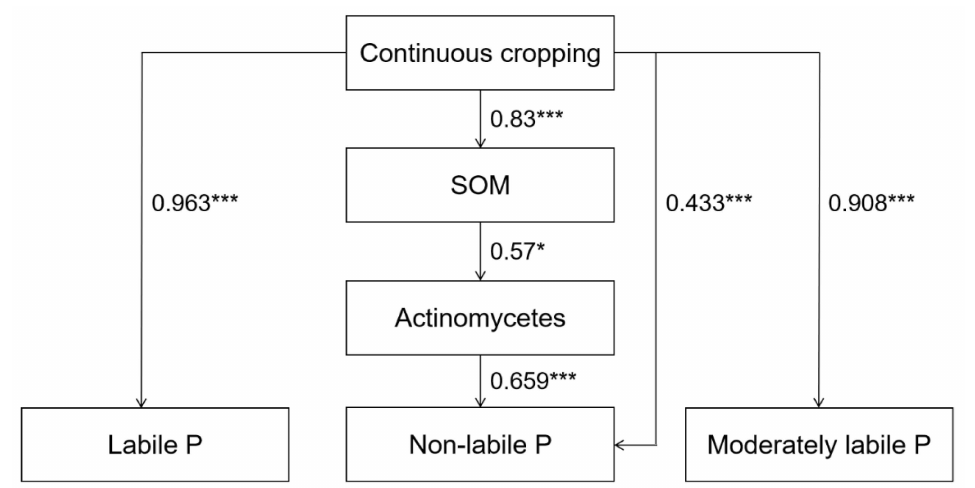
Figure 8. Structural equation model (SEM) of the relationship between the soil chemical properties, microbial community composition, and P fraction under long-term continuous cropping. The black arrow represents the path direction, the solid black line represents the positive significant correlation, and there is no negative correlation in this model. The numbers on the arrows indicate the strength of the standardized path coefficients, and the R 2 value represents the proportion of variance explained by each endogenous variable. * and *** indicate significant correlation at p < 0.05 and 0.001 levels,